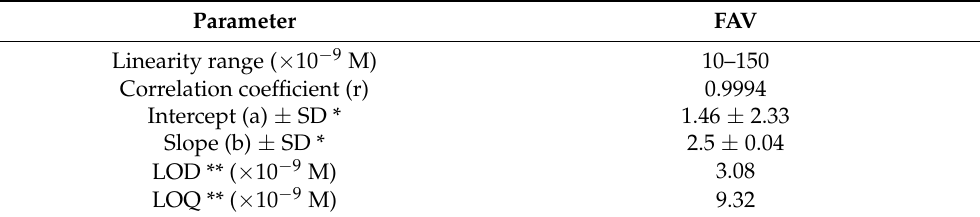
Table 1. Linearity results for FAV determination by the proposed SWV method using Tb NPS @ poly m-THB/PGE